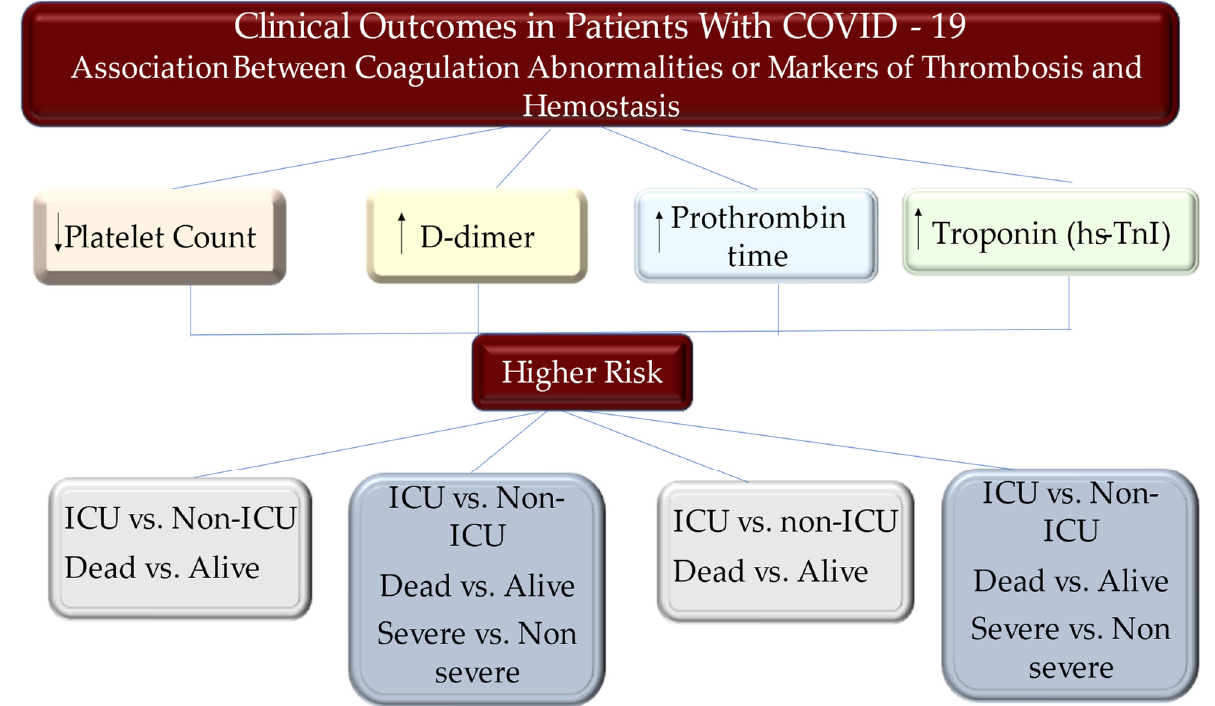
Figure 3. Patients who are infected with SARS-CoV-2 and develop COVID-19 experience consistent hemostatic abnormalities, of which, the most relevant comprise mild thrombocytopenia and increased D-dimer levels, which are related with a greater risk of demanding the benefit of mechanical ventilation, intensive care unit (ICU) admission, or death. Disease gravity may reveal variability of the modification of other coagulative parameters, such as a prolongation of the PT, international, and TT. The increased troponin level is associated with higher risk of STEMI and death. Abbreviations ICU, intensive care unit; PT, prothrombin time; TT, thrombin time. Ref [9–